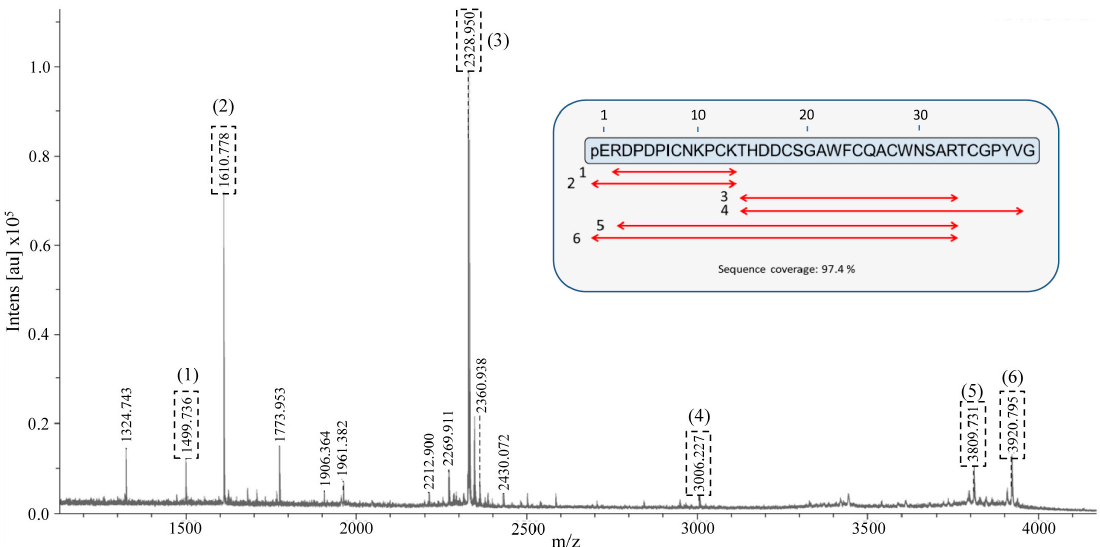
Figure 5. Peptide Mass Fingerprint profile of native chuPCI. MALDI-TOF mass spectra of the tryptic peptides resultant from the PMF analysis of the native chuPCI. Boxed peaks are those tryptic fragments that match the theoretical peptides generated by tryptic digestion of the rchuPCI sequence. For the analysis different post-translational modifications of rchuPCI were considered: (I) cyclization of the N-t Gln amino acid (conversion to pyroglutamic acid); (II) cleavage of the N-terminal Gln/cleavage of the N-terminal pyroglutamic acid; (III) cleavage of the C-terminal Gly. See Table S1 for more details. The inset shows the sequence coverage (red arrows) of each peptides from the PMF analysis. The final sequence coverage for the full-length inhibitor was 97.4% (100% for the C-terminally truncated inhibitor).